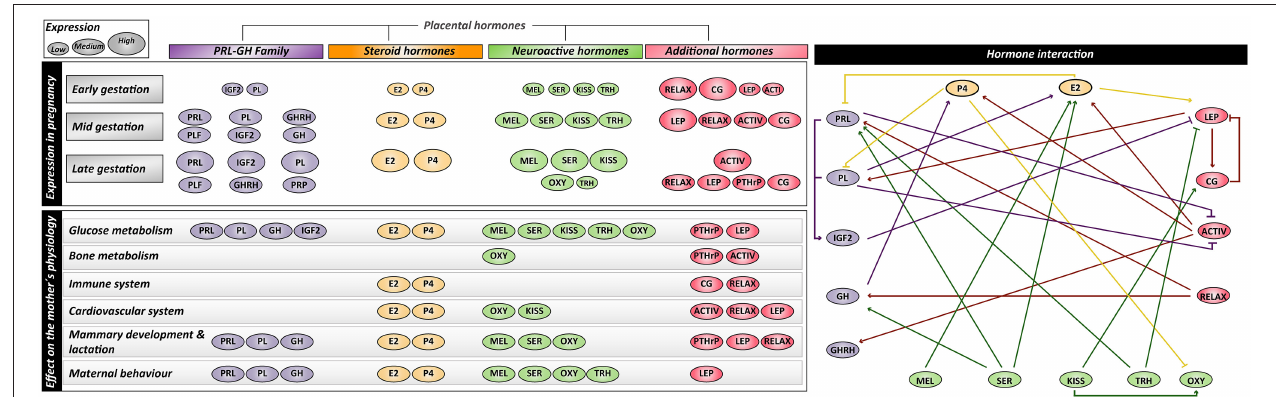
FIGURE 2 | Summary of expression profiles, interactions and maternal physiological effects of placental-derived hormones. PRL, prolactin; PL, placental lactogen; PLF, proliferins; PRP, proliferin-related proteins; GH, growth hormone; GHRH, growth hormone releasing hormone; IGF1/2, insulin-like growth factor-1/2; E2, estrogen; P4, progesterone; MEL, melatonin; SER, serotonin; KISS, kisspeptin; OXY, Oxytocin; TRH, thyrotropin-releasing hormone; RELAX, relaxin; ACTIV, activin; CG, chorionic gonadotropin; LEP, leptin; PTHrP, parathyroid hormone-related